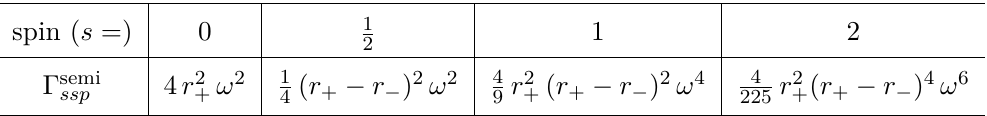
Table 1 . The greybody factors for various massless spin particles with l = s in the limit of T (cid:28) 1 /r e and ω (cid:28) 4 πT and based on the semiclassical calculation, which is valid for T (cid:29) Λ gap . radiating uncharged quanta, the greybody factor is defined using the expected number of particles in radiation as